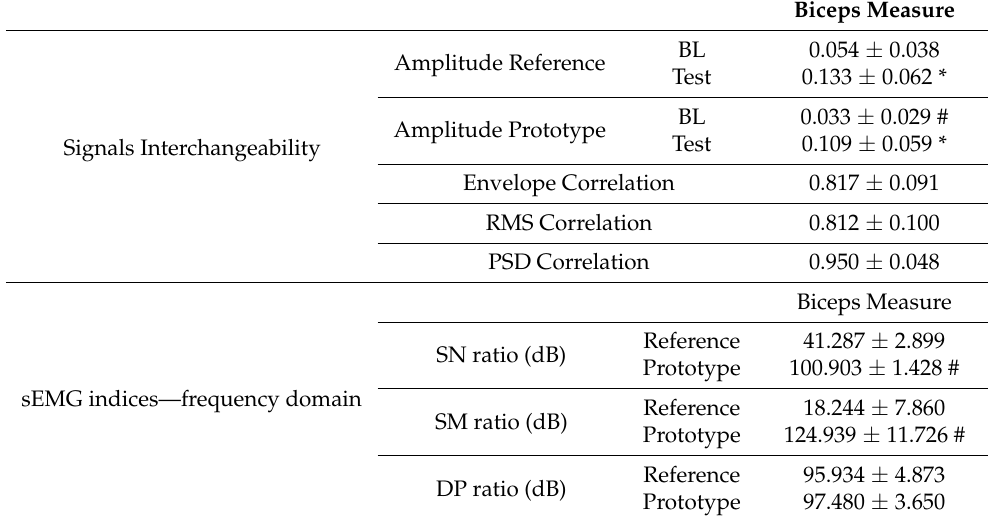
Table 3. Results for EMG Indices.